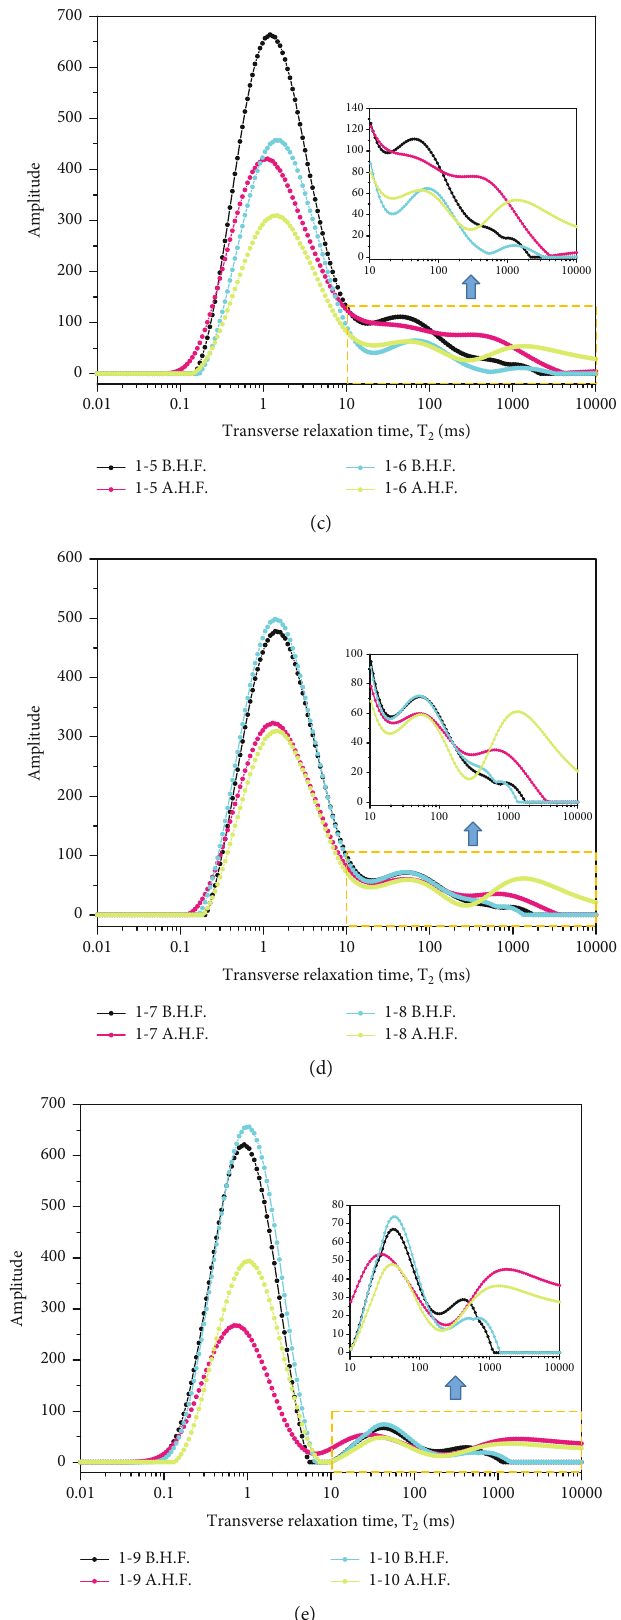
Figure 9: T spectra for sandstone samples before and after hydraulic fracturing. (a) θ = 0 ° . (b) θ = 15 ° . (c) θ = 30 ° . (d) θ = 45 ° . (e) θ = 60 ° 2